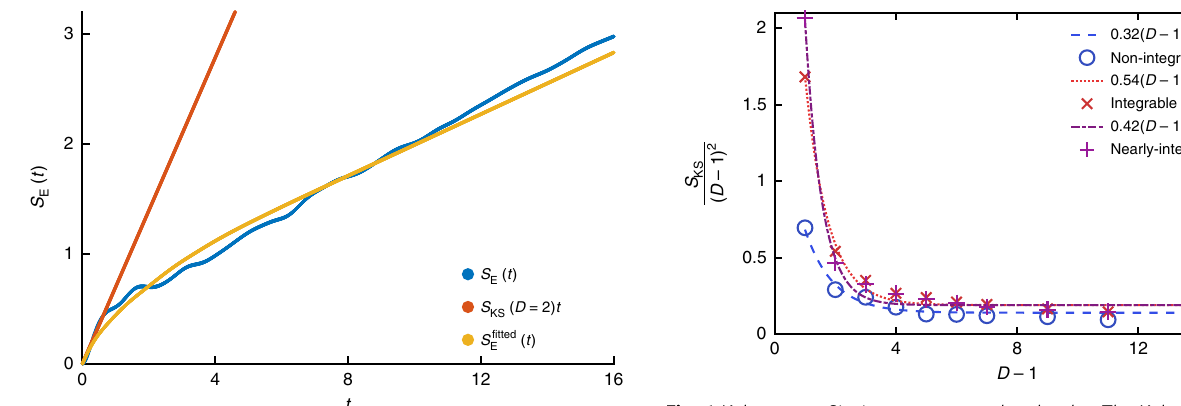
Fig. 6 Kolmogorov – Sinai entropy versus bond order. The Kolmogorov – Sinai entropy scaled by ( D − 1) 2 is related to entanglement growth at short times. Here, we show the scaled KS entropy varying with bond order for non- integrable (circles), integrable (crosses) and nearly integrable (pluses) systems. The non-integrable KS entropy decreases like 0.14 + 1.6 e − 1.08( D − 1) , the Integrable KS entropy decreases like 0.19 + 6.6 e − 1.32( D − 1) and the